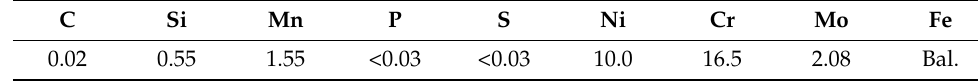
Table 3. Chemical composition (wt%) of 316L stainless steel.